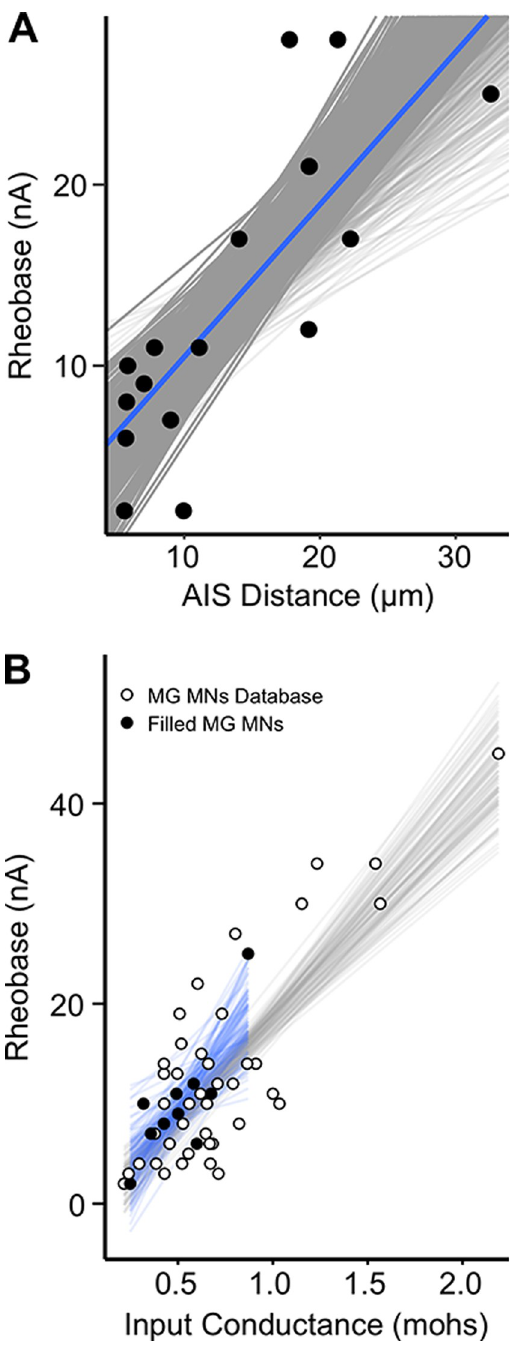
Fig 3. AIS d covaries with rheobase. Comparisons were performed using a Bayesian analytical approach to calculate a posterior probability distribution. Plots are based on a generative model conditioned on previous reports and the current data set. Each grey line represents a single trial from 4,000 generative samples and each black dot is an observed data point (n = 16). From the 4,000 samples we provide a 95% high density interval (HDI). The median slope from the generative sample is represented as a blue line ( β 1 ). From the slopes and generative model, we compute an R 2 equivalent, and this is presented with an HDI and a median. (A) Rheobase: AIS distance. As rheobase increases the AIS distance increased from the motoneuron soma. Model slope: 95% HDI 0.463–1.21, β 1 = 0.846; R 2 : 95% HDI 0.364– 0.732, median R 2 0.631 . (B) Close similarity in rheobase and input conductance between two samples of MG motoneurons. A hierarchical Bayesian model was constructed for 44 MG motoneurons (white filled circles, grey lines) pooled from a larger MG motoneuron database produced by the Cope lab and for 10 MG Neurobiotin